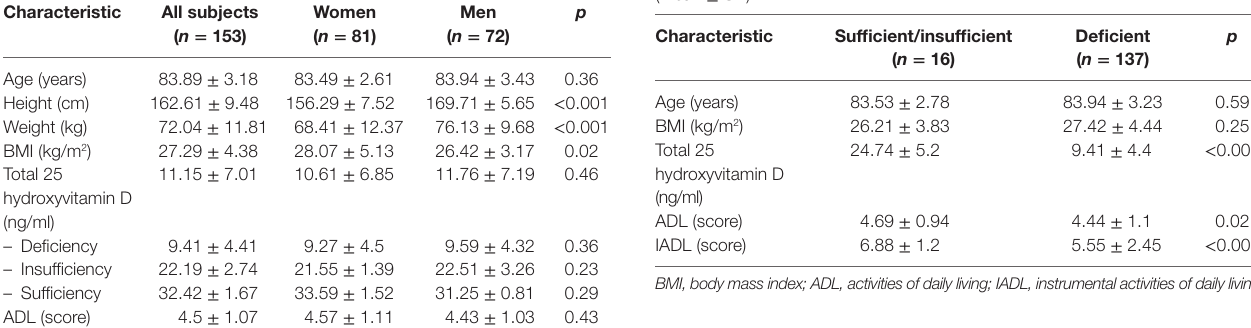
Table 3 | Characteristics of study population in vitamin D status groups (mean ± SD).